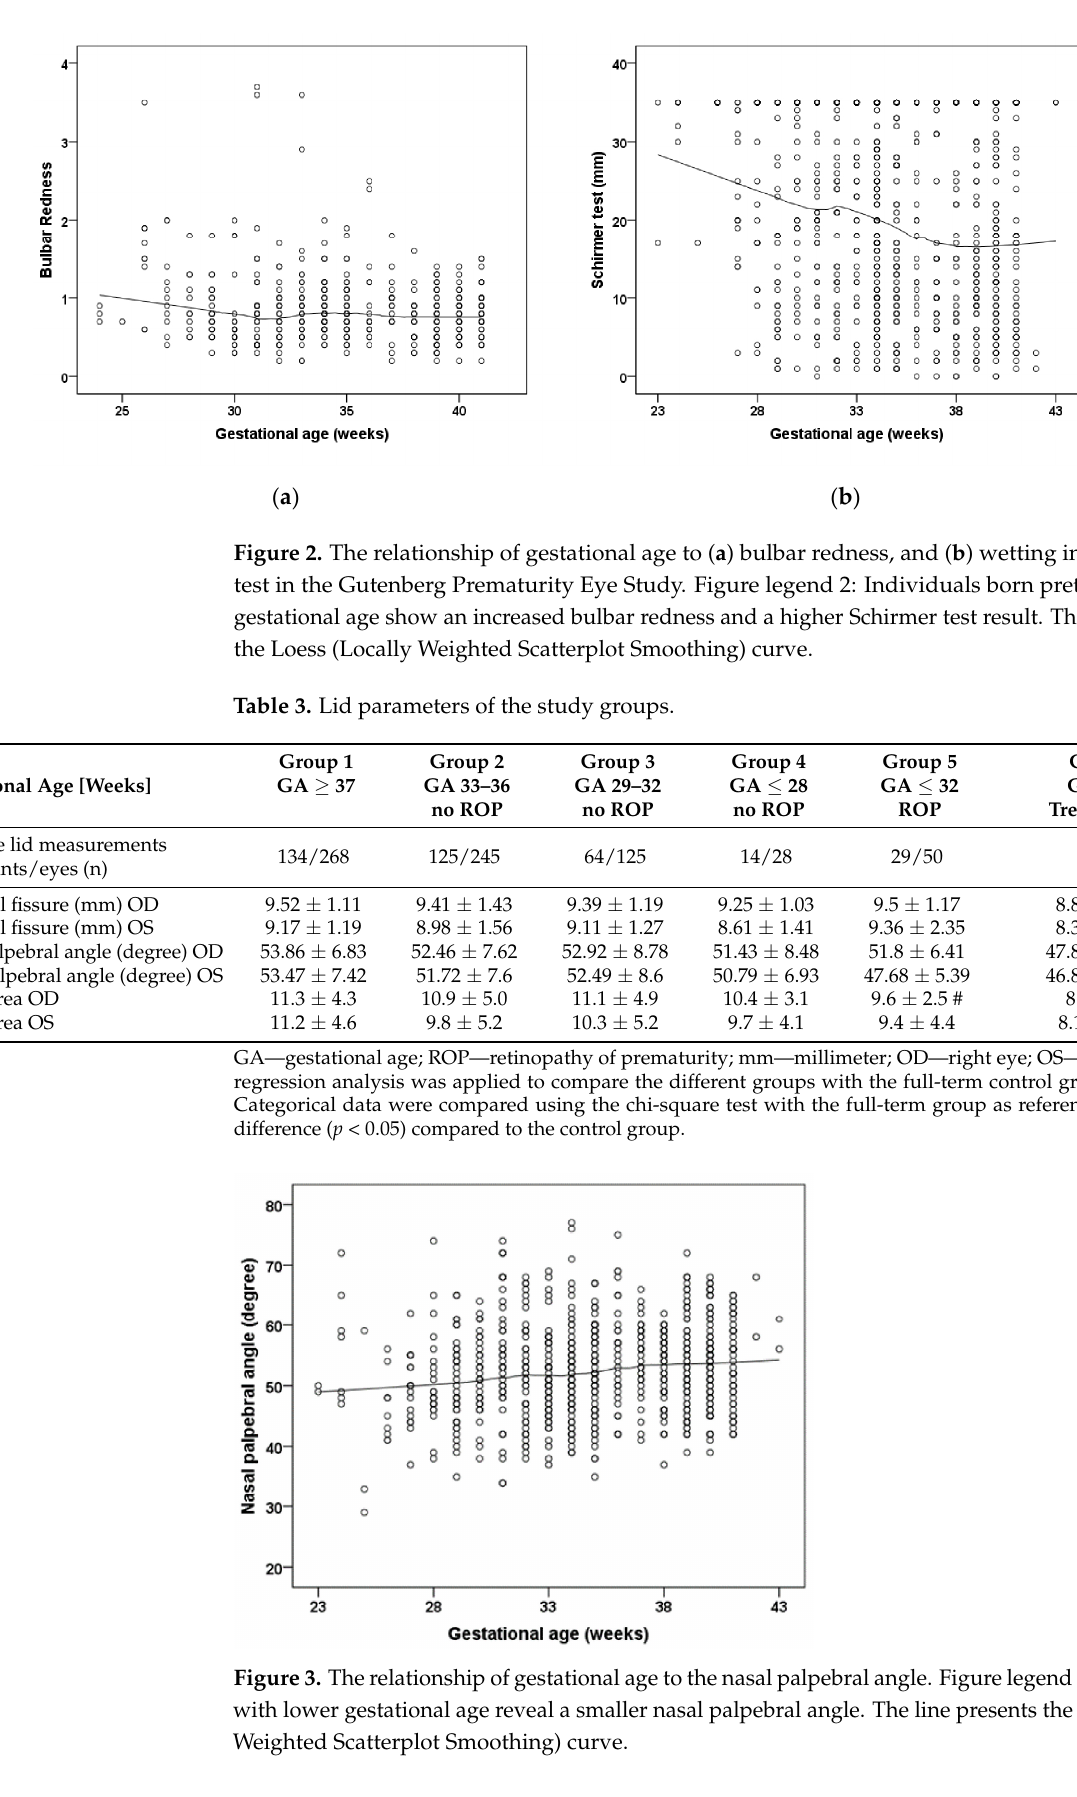
Figure 1. Relationship of ( a ) gestational age and ( b ) birth weight percentile to the first break-up time (sec.) in the Gutenberg Prematurity Eye Study. Figure legend 1: There is no significant association between low gestational age and low birth weight percentile with first break-up time. The line pre- sents the Loess (Locally Weighted Scatterplot Smoothing) curve.